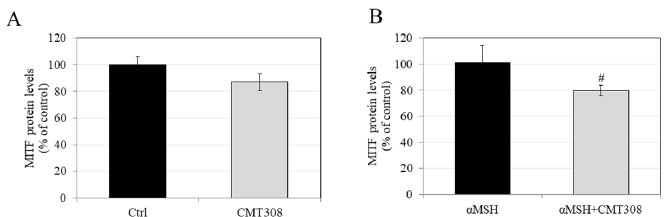
Figure 5. Effects of CMT-308 on MITF protein expression in B16F10 cells under ( A ) basal and ( B ) α -MSH-stimulated conditions; data are mean ± SD of three replicates; # p < 0.01 vs. α MSH; unpaired-student’s t -test.